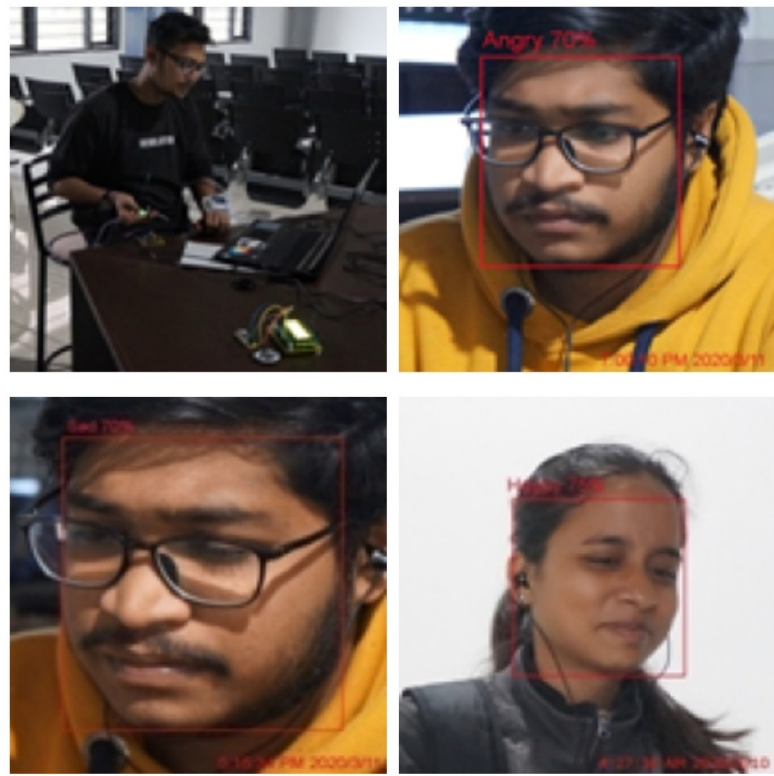
Figure 13. Expressions captured via the experimental setup with a timestamp.